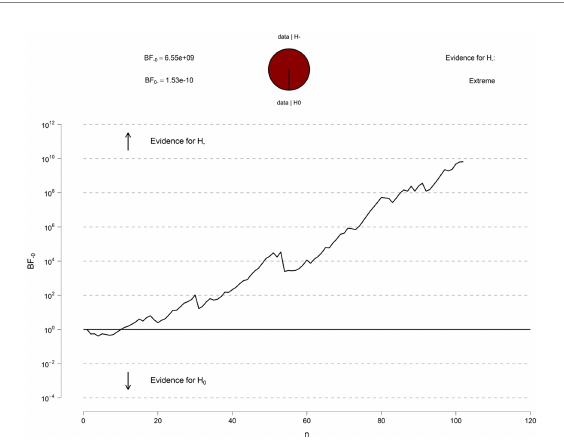
FIGURE 5 Results of the sequential analysis for the effect of time on skill.